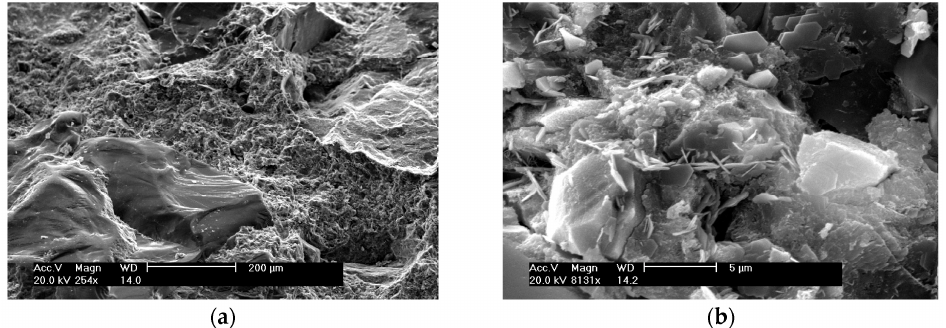
Figure 2. SEM image of concrete with the following composition: ordinary Portland cement CEM II 52.5 (EN 197-1:2000), naphthalene-based superplasticiser, river sand and crushed granite as fine and coarse aggregates, respectively, and a water-to-binder ratio of 0.3 (reproduced from [55]): ( a ) Magnification of 254; and ( b ) Magnification of 8131.